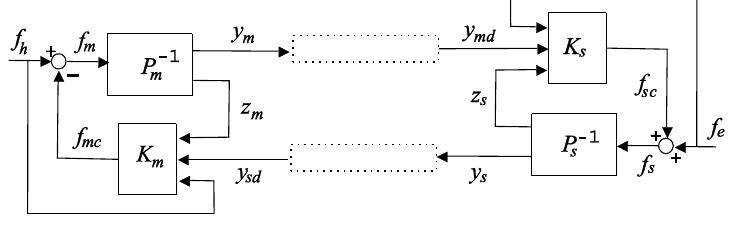
Figure 1. Generic teleoperation system.